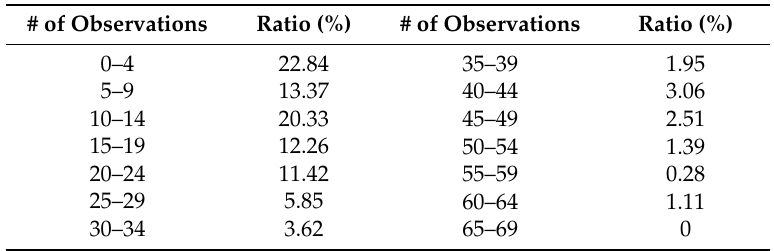
Figure 7. The ratio of the number of Compass-G1 observations at Changchun in 2017. Table 4. The ratio of the number of Compass-G1 measurements at Changchun in 2017.